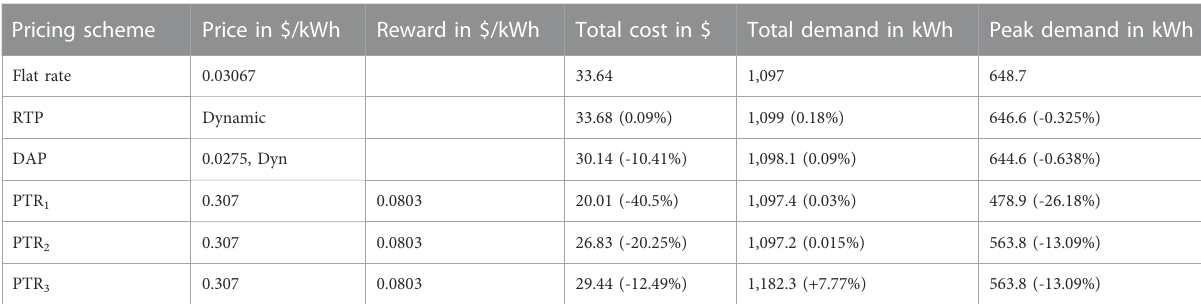
TABLE 6 Results of November